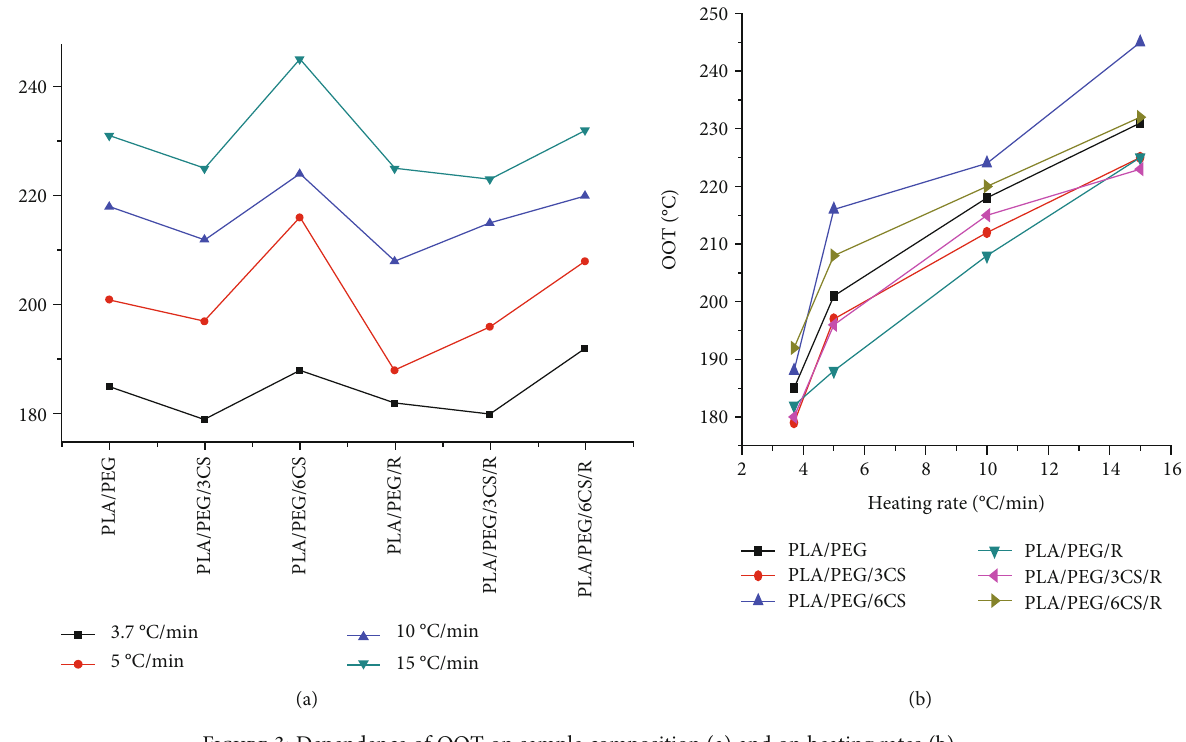
Figure 3: Dependence of OOT on sample composition (a) and on heating rates (b).